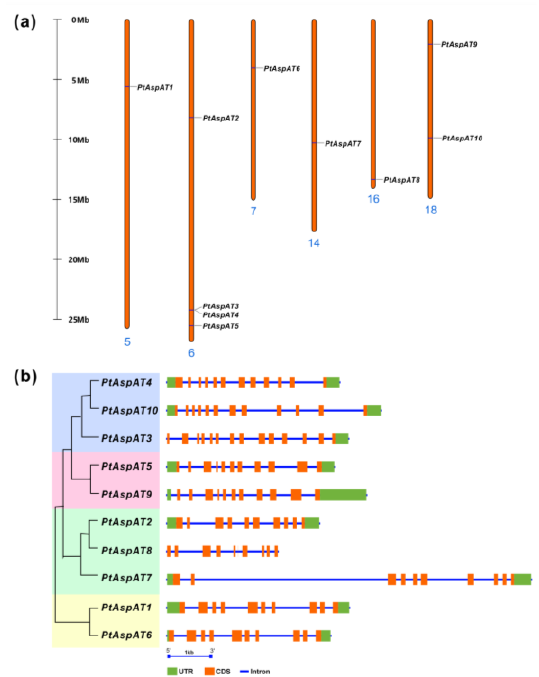
Figure 2. Chromosomal distribution and the genomic structures of PtAspATs . ( a ) Ten PtAspATs were anchored on six chromosomes. ( b ) Gene structures showing the exon intron organization of PtAspATs that were analyzed by the online tool GSDS. Lengths of the exons and introns of PtAspATs are displayed proportionally to the scale on the bottom. The classification of PtAspATs is indicated by the phylogenetic tree on the left.